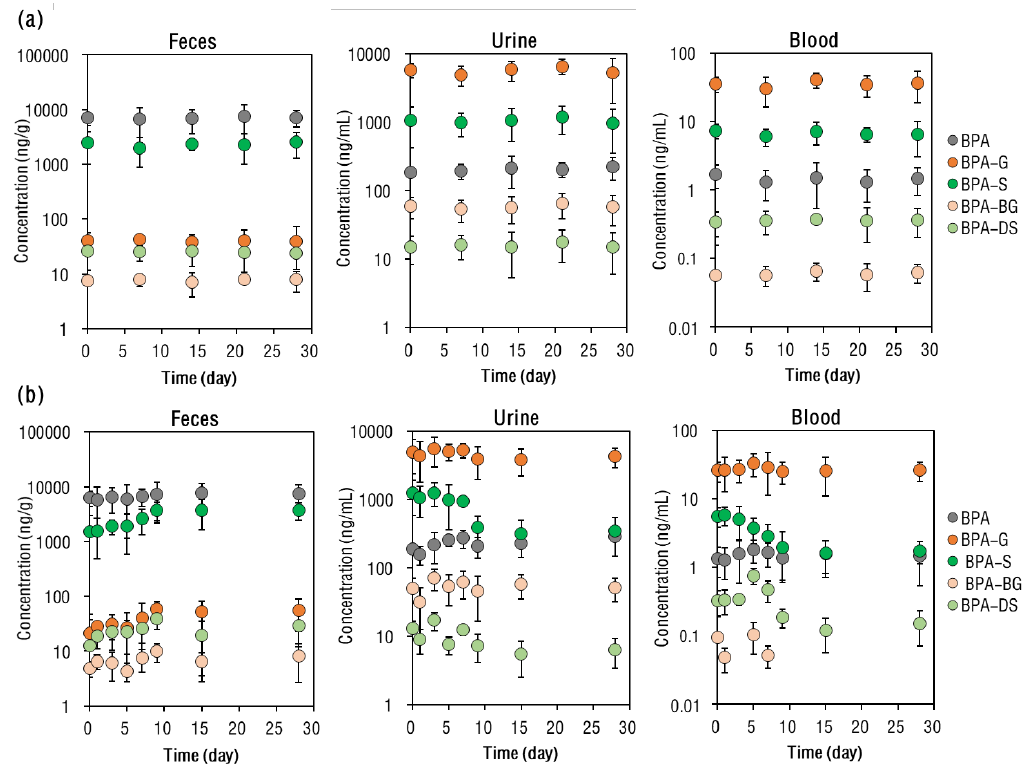
Figure 3. Mean concentrations of BPA and its conjugated metabolites in SD rat feces, urine, and blood, following ( a ) intervallic and ( b ) continuous oral BPA administration. The vertical bars represent standard deviation.